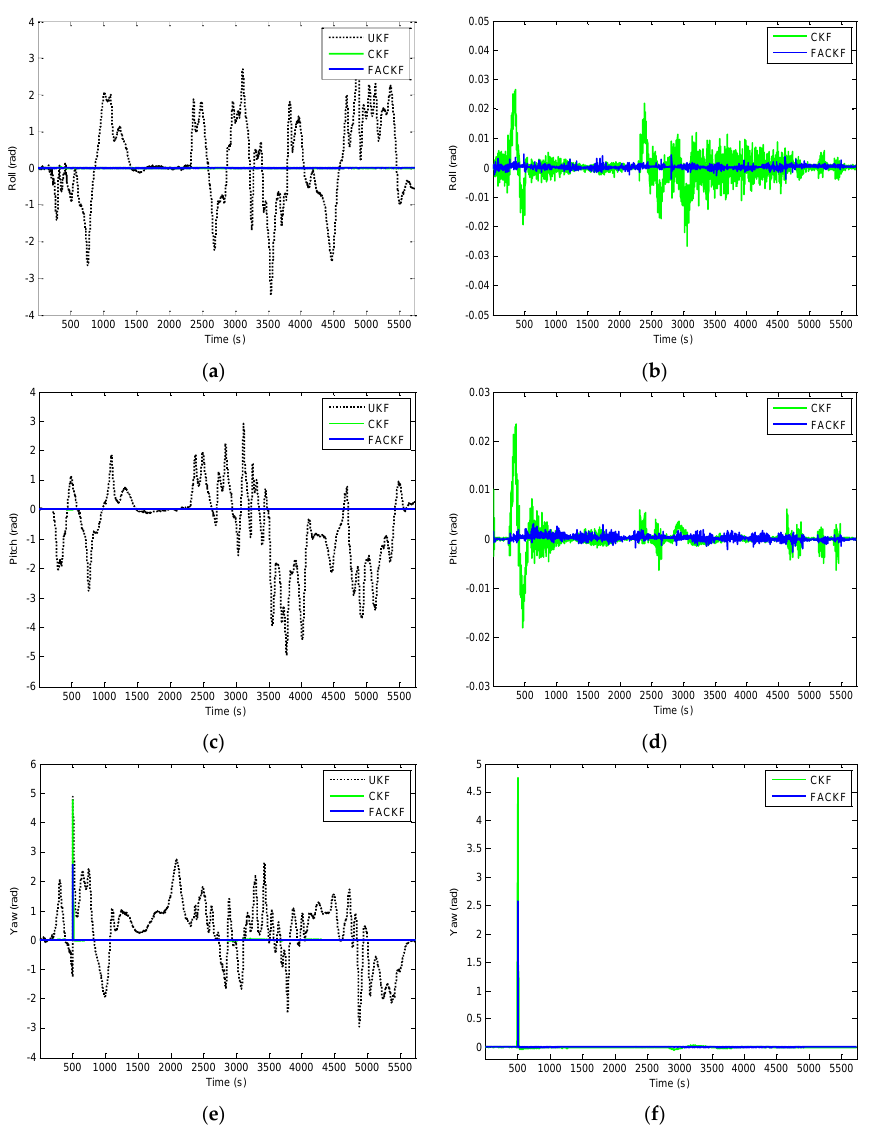
Figure 15. Comparison of Euler angle errors for UKF, CKF, and FACKF—Scenario 2: ( a,c,e ) UKF, CKF and FACKF; and ( b,d,f ) CKF versus FACKF. Table 7. Summary of RMS errors and the time consumption for Scenario 2. RMS Errors (in Units of m for Positions and Rad for Angles, Respectively) East North Altitude Roll Pitch Yaw EKF